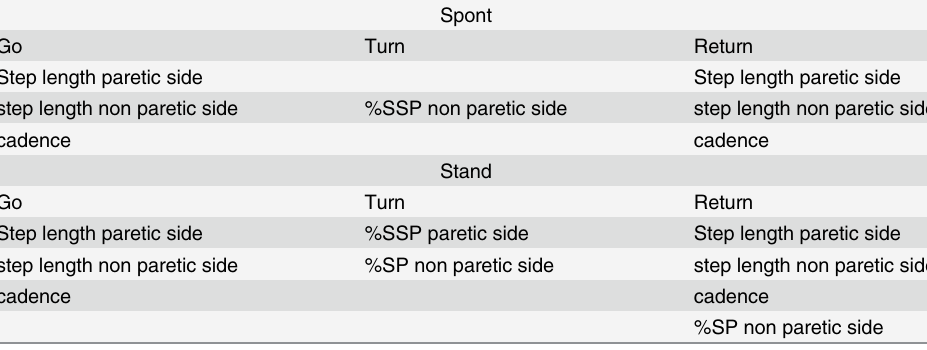
Table 3. Stepwise results for each sub-task and both conditions (Spont and Stand). Spont Go In Stand. For Go, step length on both sides and cadence were selected, explaining 95% of the variance of Go performance. ¼ 13 : 38 (cid:2) 0 : 06 paretic Step length (cid:2) 0 : 04 Cadence (cid:2) 0 : 05 non (cid:2) paretic Step length For Turn, non-paretic %SPand paretic %SSP were selected, explaining 56% of the variance of Turn performance. Turn performance ¼ 5 : 23 (cid:2) 0 : 39 non (cid:2) paretic % SP þ 0 : 32 paretic % SSP For Return, non-paretic %SP, cadence and step length on both sides were selected, explain- ing 87% of the variance of Return performance.